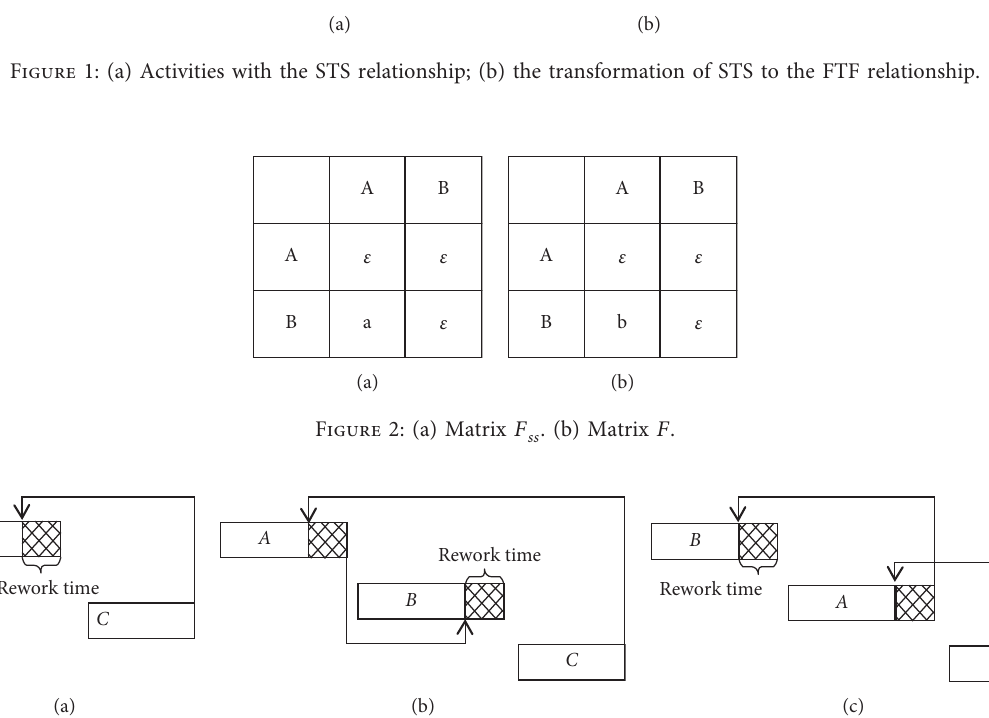
Figure 3: The first and second rework time. (a) The first rework, (b) the second rework caused by information transition from its precedent activity, and (c) the second rework caused by information feedback from its successive